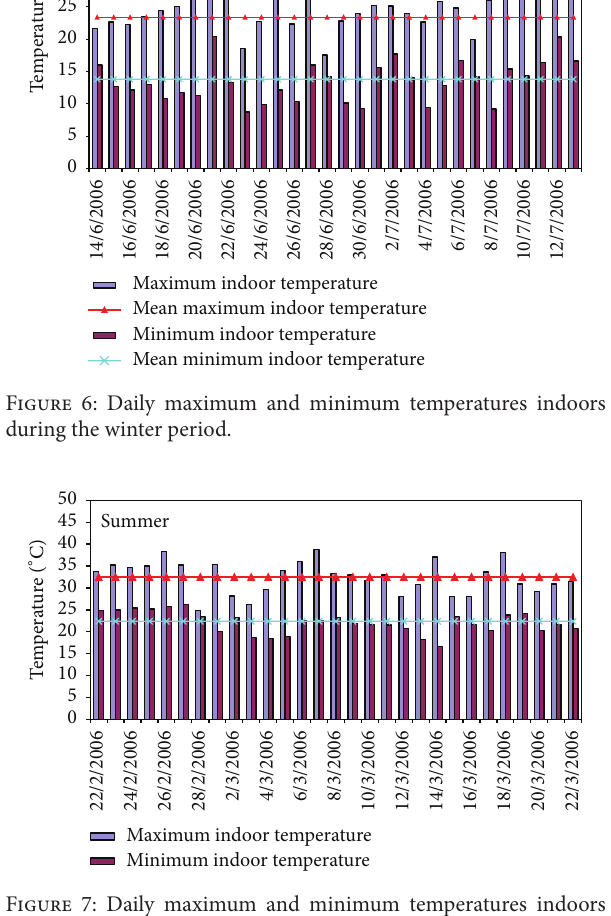
Figure 7: Daily maximum and minimum temperatures indoors during the summer